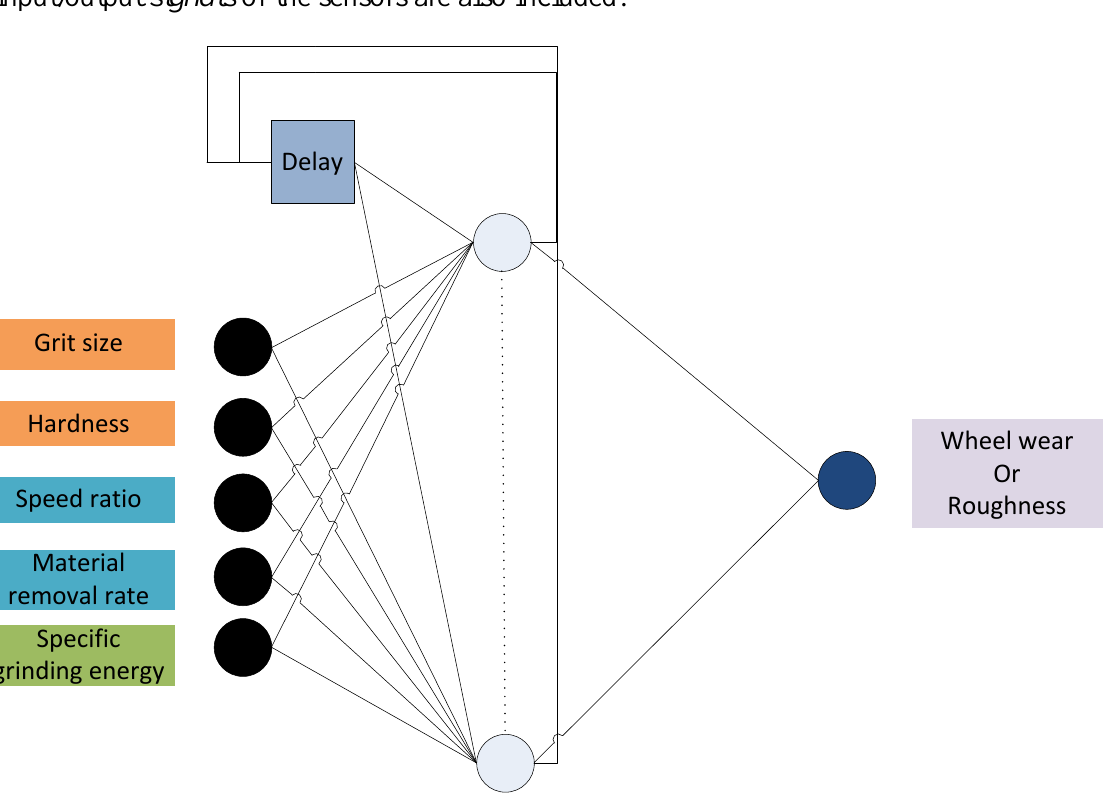
Figure 1. Layer-Recurrent Neural Network for wheel wear and roughness prediction. The input/output signals of the sensors are also